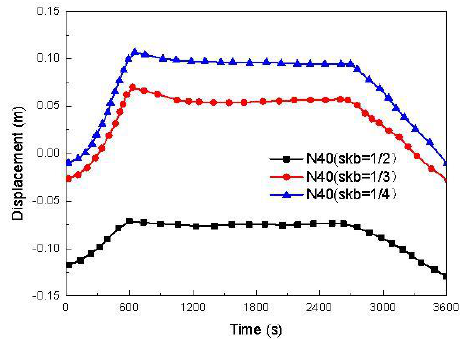
Figure 24. Time-history curve of vertical displacement (influence of the rise span ratio).